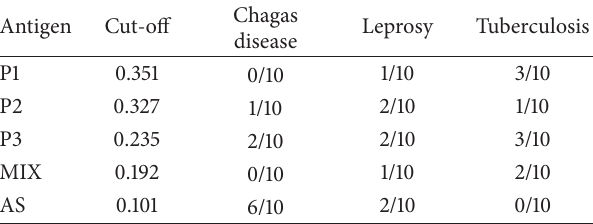
Table 3: Reactivity of peptides (P1, P2, and P3 and MIX) and soluble antigen (SA) against sera from patients with Chagas disease, leprosy, and tuberculosis. The cut-off was provided by the ROC